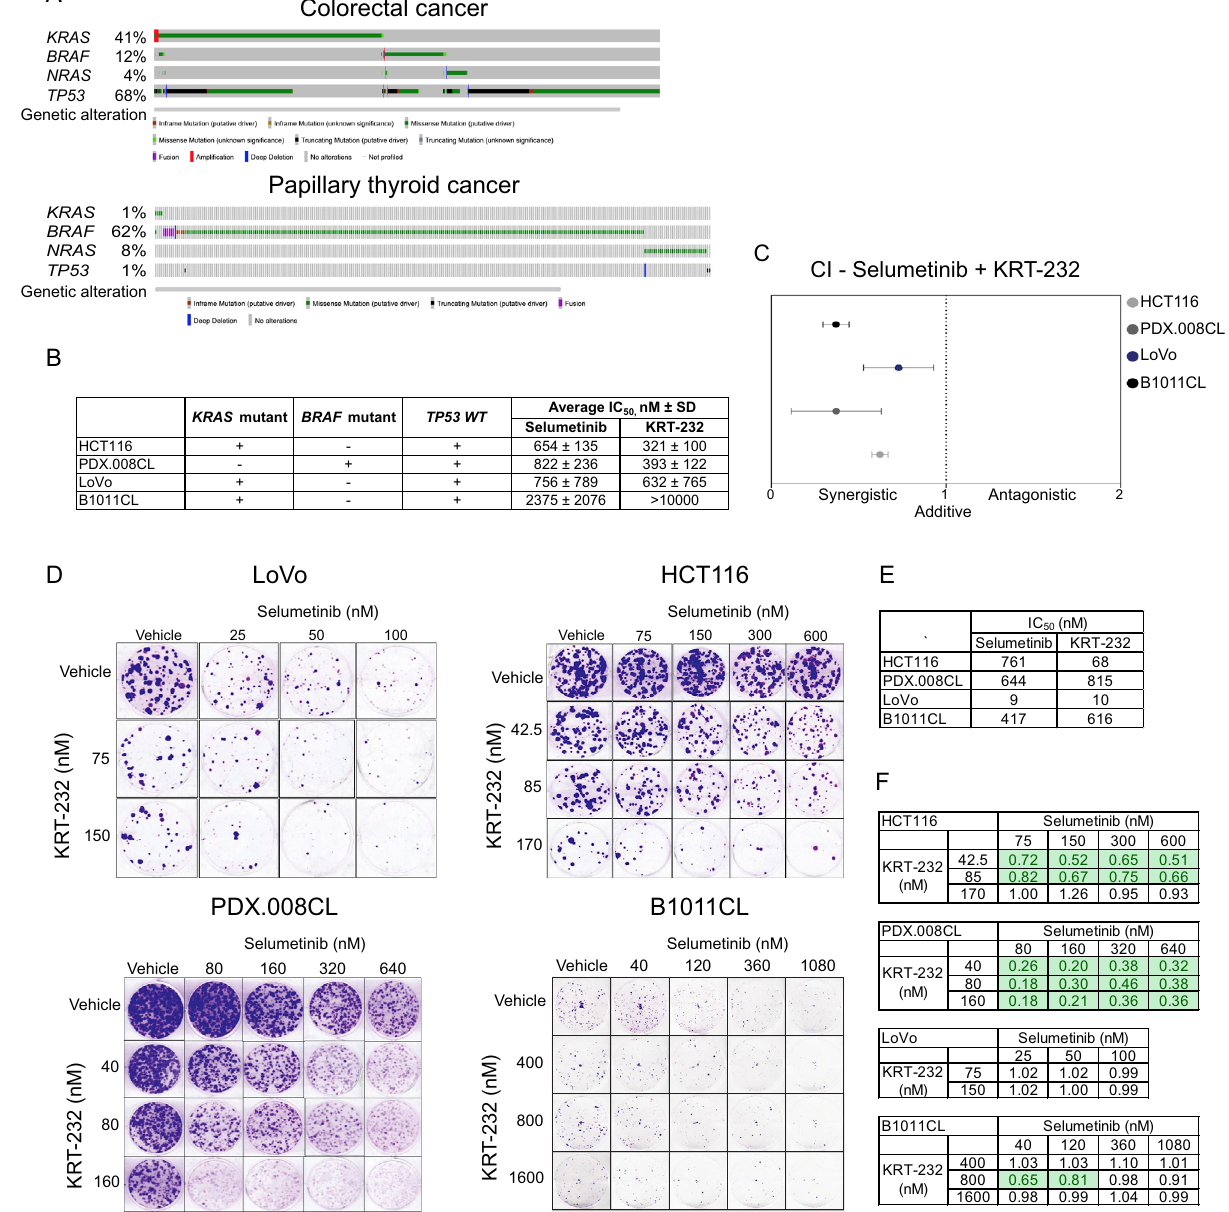
Figure 1. In vitro synergistic effects of MDM2 and MEK inhibition in CRC and PTC. (A) TP53 and MAPK pathway gene alteration frequencies in human CRCs and PTCs. (B , C) Three CRC cell lines (LoVo, HCT116, and B1011CL) and one PTC cell line (PDX.008CL) were treated for 72 h with increasing concentrations of vehicle, selumetinib, KRT-232, or a combination of both. Drug toxicity and cell growth were determined using sulforhodamine B assay. Individual IC 50 values (B) and combination indices (C) are shown. KRT-232 IC 50 was beyond the tested drug concentration range. CI < 1 indicates synergistic activity. IC 50 and CI values were calculated using CalcuSyn. (D) Colony formation assays of three CRC and one PTC cell line. Cells were treated with vehicle or various doses of selumetinib, KRT-232, or their combination for 2–3 weeks. This was followed by fixation of colonies and staining using crystal violet. (E) Individual IC 50 values were calculated using CalcuSyn. (F) The Bliss independence model was used to evaluate the drug interaction across all dose combinations tested. Interaction index values < 1 indicate synergy and values within 0–0.9 range were highlighted in green. All experiments were repeated at least three